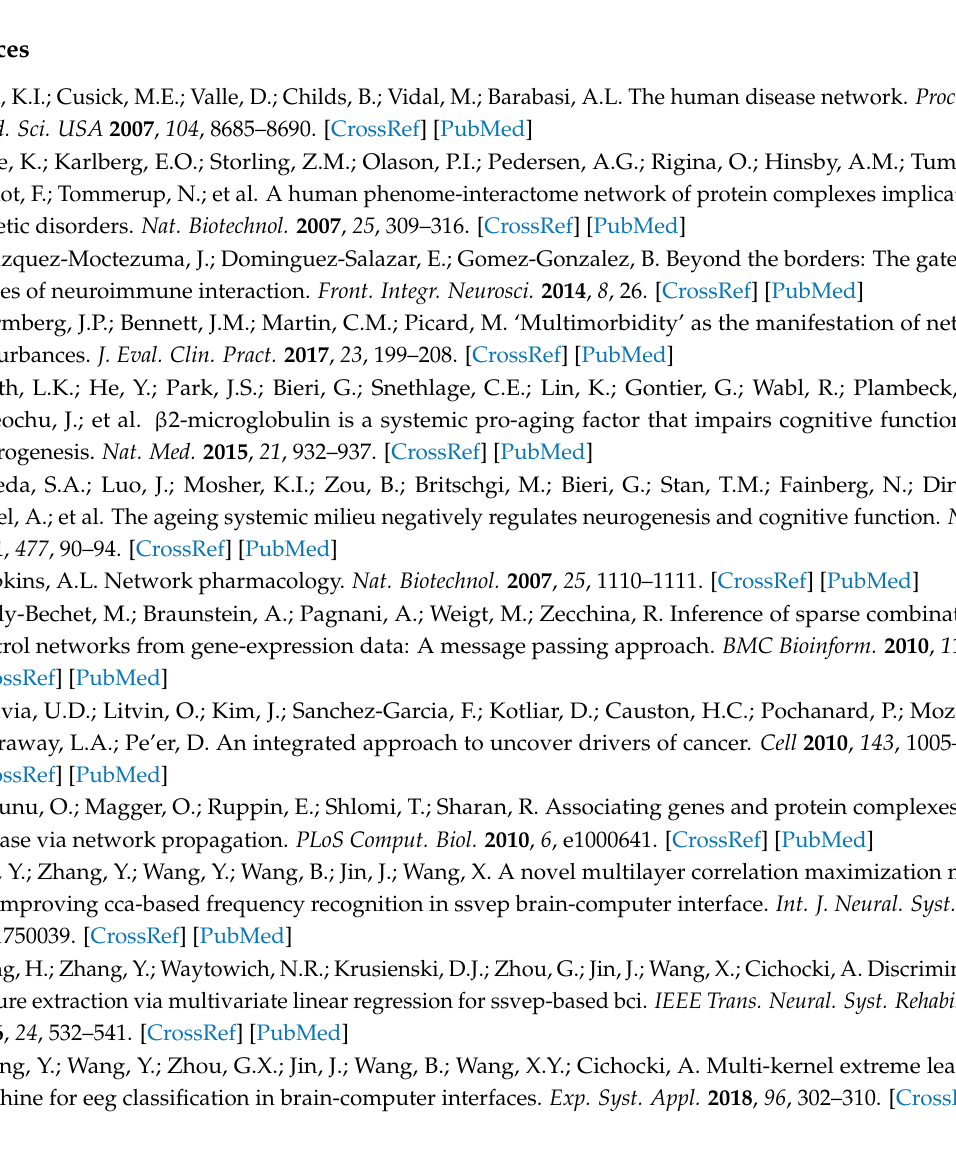
network from NSSM to ISSM; Table S14: The network topology parameter data for the regulatory network from ESSM to NSSM; Table S15: The network topology parameter data for the internal regulatory network of ESSM; Table S16: The network topology parameter data for the regulatory network from ESSM to ISSM; Table S17: The network topology parameter data for the regulatory network from ISSM to NSSM; Table S18: The network topology parameter data for the regulatory network from ISSM to ESSM; Table S19: The network topology parameter data for the internal regulatory network of ISSM; Table S20: The gene expression profile signature of RA; Table S21: The gene expression profile signature of AD; Table S22: The network topology parameter data for the RA-specific NIM subnetwork; Table S23: The network topology parameter data for the AD-specific NIM subnetwork; Table S24: The edge data of the RA-specific NIM subnetwork; Table S25: The edge data of the AD-specific NIM subnetwork; Table S26: The biomarker dataset of RA downloaded from the MetaCore database; Table S27: The biomarker dataset of AD downloaded from the MetaCore database; Table S28: The extended network of NIM signaling